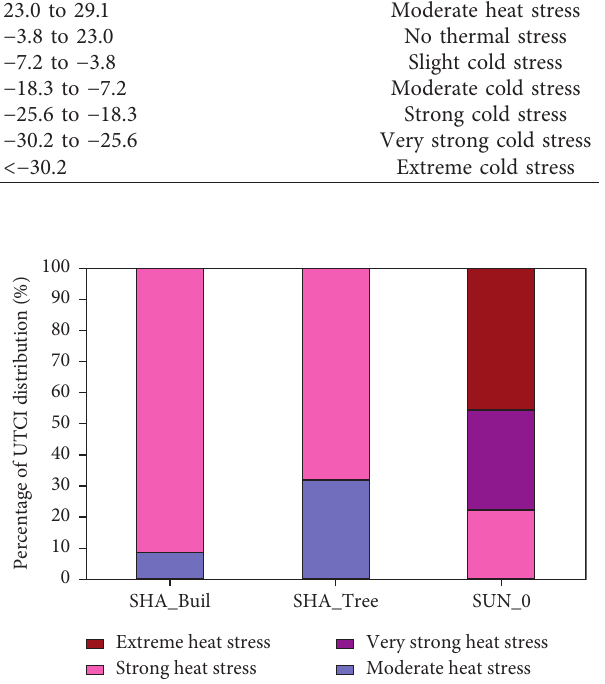
Figure 15: Histograms of seven-day UTCI distributions. Table 6: Partial correlation analysis results of UTCI depending on the microclimatic parameters at the shaded and sunlit research